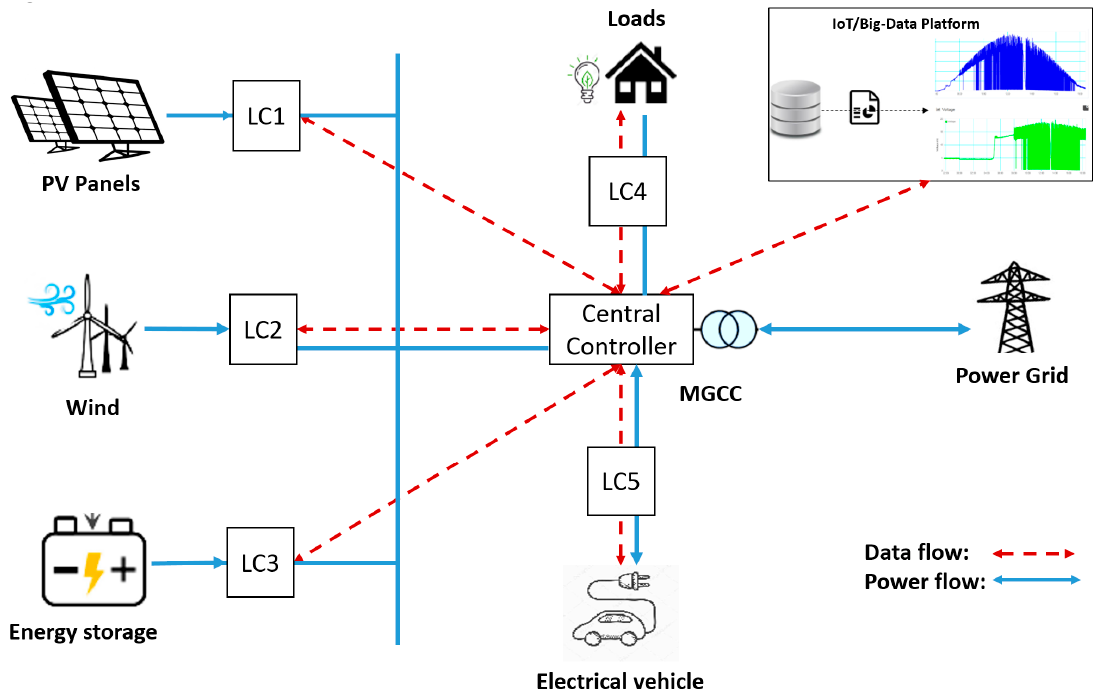
Figure 2. Centralized control